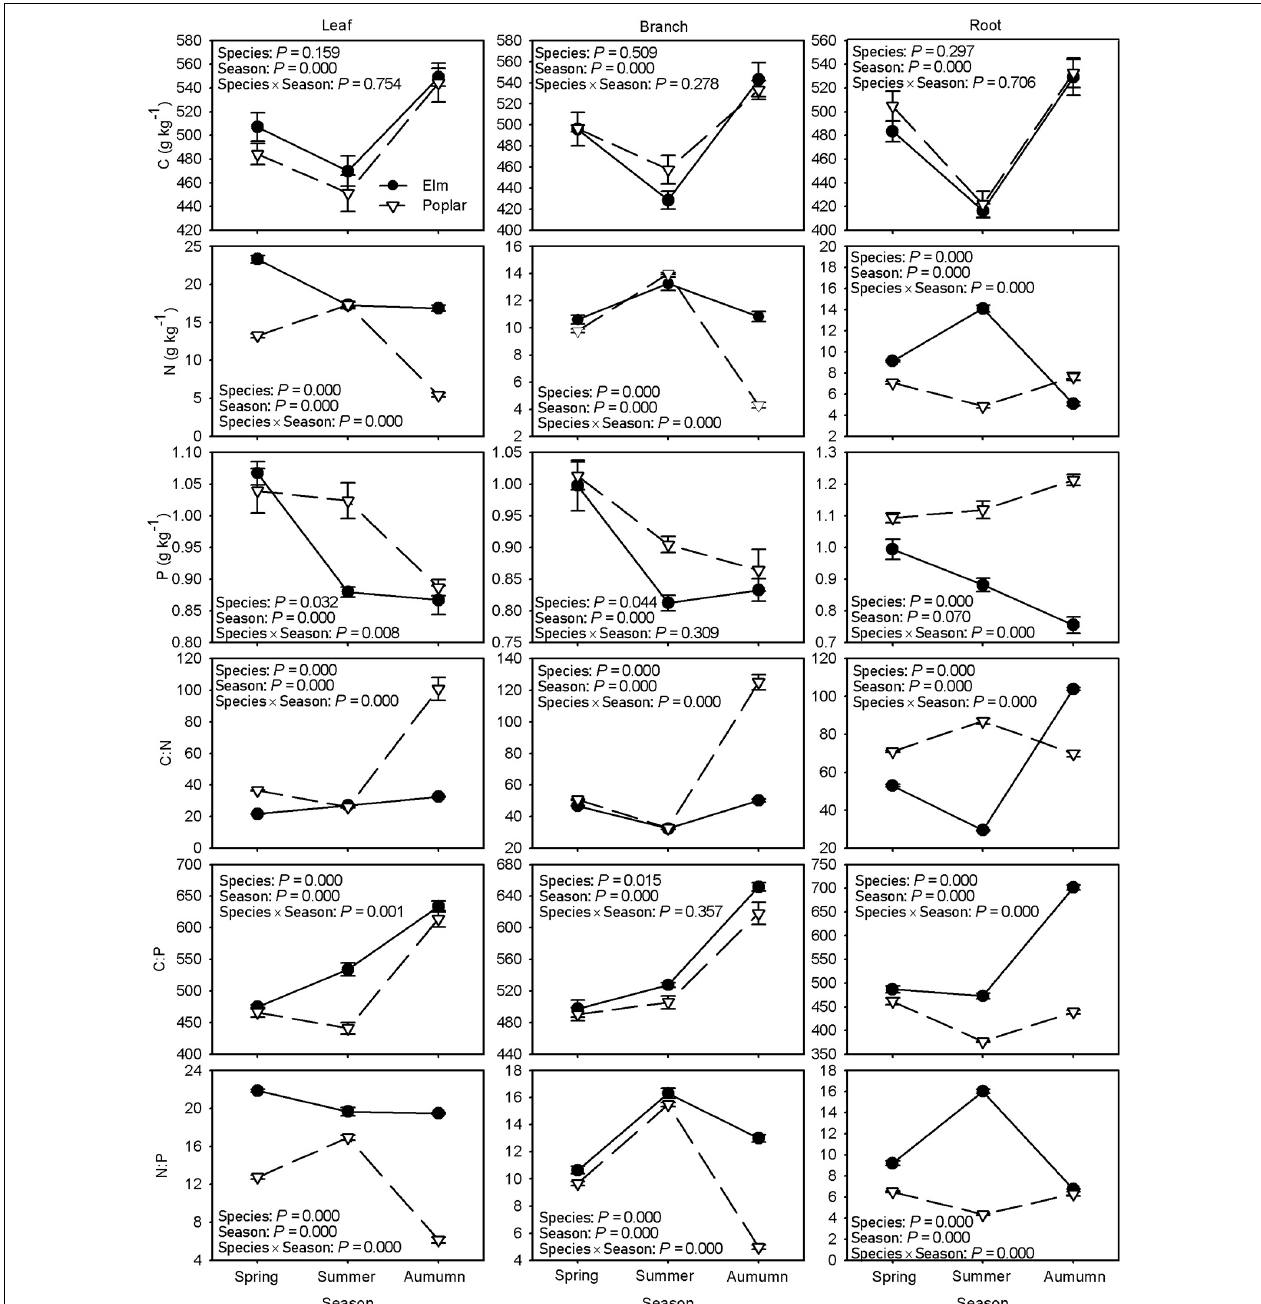
FIGURE 3 | Differences in organ C, N, and P concentrations and C:N, C:P, and N:P across the growing season between Siberian elm and Silver poplar plantations ( n = 3).